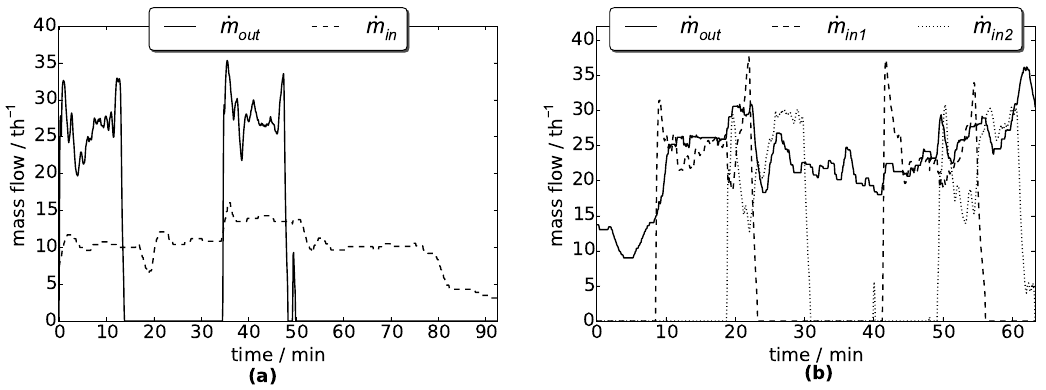
Figure 8. Charging and discharging mass flow. ( a ) Example 1. ( b ) Example 2.